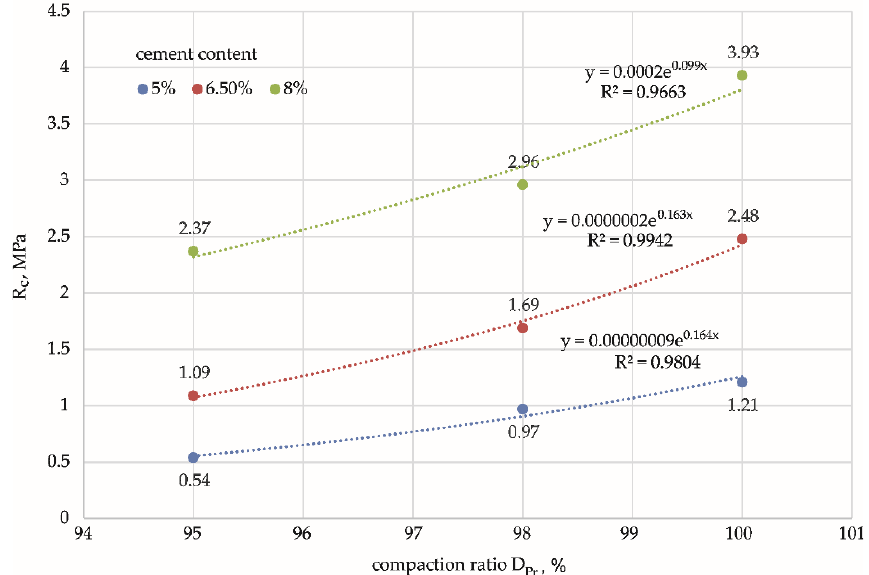
Figure 6. Effect of compaction ratio, 𝐷 𝑃𝑟 , on compressive strength, 𝑅 𝑐 , for mixtures with different cement contents. Cement content: — 5%, — 6.5%, — 8%.